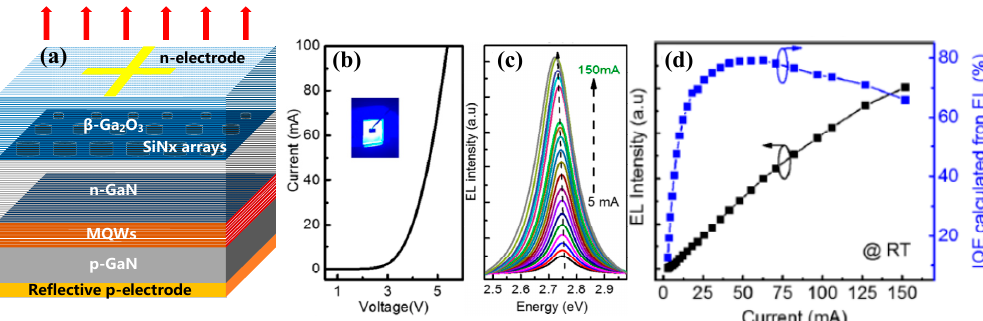
Figure 14. ( a ) Schematic structure of InGaN/GaN MQW vertical structure light emitting diodes (VLED). ( b ) I − V curve from InGaN/GaN MQWs VLED grown on β -Ga 2 O 3 substrate (image of EL emission at 20 mA is shown in the inset). ( c ) EL spectra as a function of the injection current for the VLED. ( d ) EL intensity and IQE as functions of the injection current for the VLED. Reprinted with permission from reference [102]. Copyright 2017 American Chemical Society.